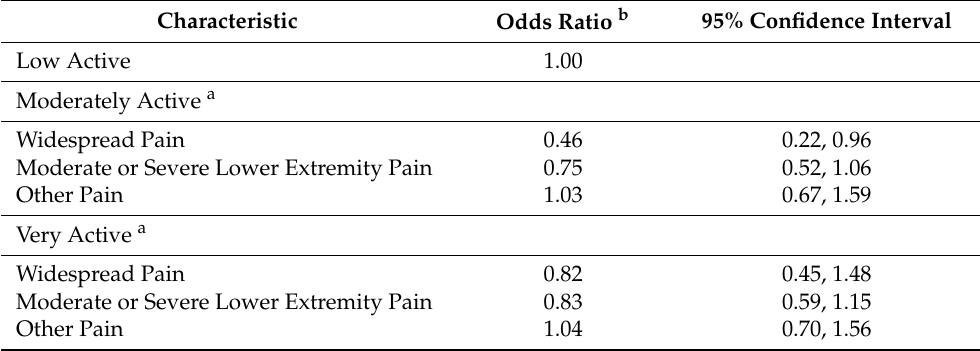
Table 3. Odds Ratios from Marginal Structural Models for the Association of Pain Status with Low Physical Activity, Women’s Health and Aging Study II, Baltimore, MD, USA, 1994–2009. Characteristic Odds Ratio b 95% Confidence